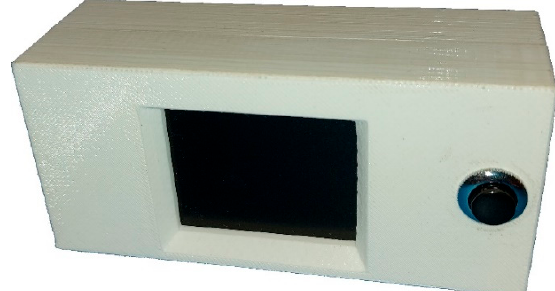
Figure 4. PTL module.